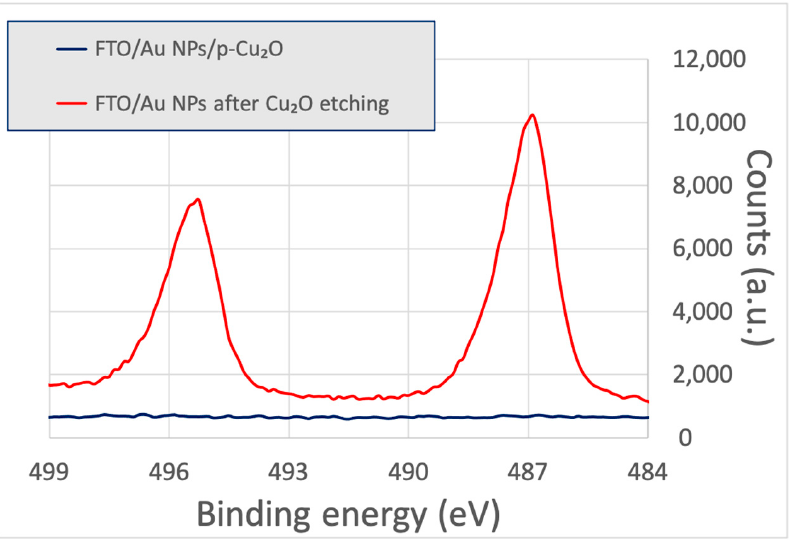
Figure 8. Sn 3d XPS detail scan analysis of the FTO/Au NPs/p-Cu 2 O and FTO/Au NPs after etching p-Cu 2 O films.